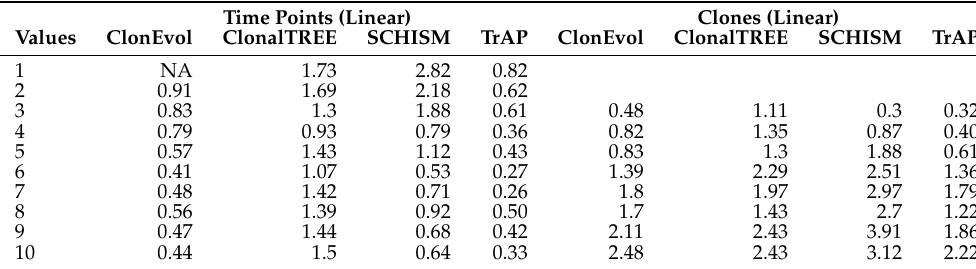
Table A4. Discrete spectral distance comparing the trees reconstructed using ClonEvol, ClonalTREE, SCHISM, and TrAP to simulate truth. Different numbers of time points and clones under the models of clonal evolution linear, branched dependent, and branched independent were simulated. Time Points (Linear) Clones (Linear) Values ClonEvol